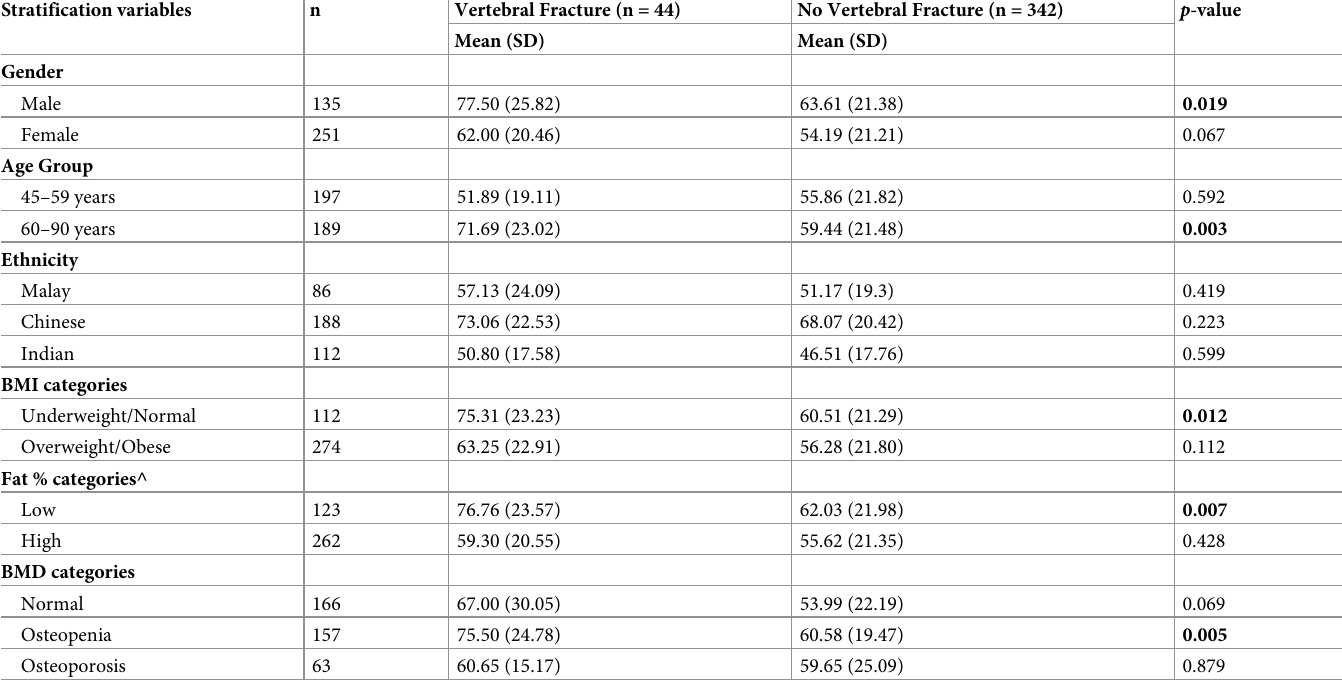
significantly higher in those with VF as compared to without VF ( p = 0.004). However, VF was not significantly associated with gender, menopausal status (in women), and BMI categories. Table 2 shows the comparisons of mean 25(OH)D levels between subjects with and without VF by gender, age groups, ethnicity, BMI categories, fat % categories and BMD categories. The results showed that those with VF had significantly higher 25(OH)D levels only in males ( p = 0.019), in the age group 60–90 years ( p = 0.003), in the underweight or normal BMI Table 2. Comparison of 25(OH)D levels between subjects with and without vertebral fracture by gender, age groups, ethnicity, BMI categories, fat percentage cate- gories, and BMD